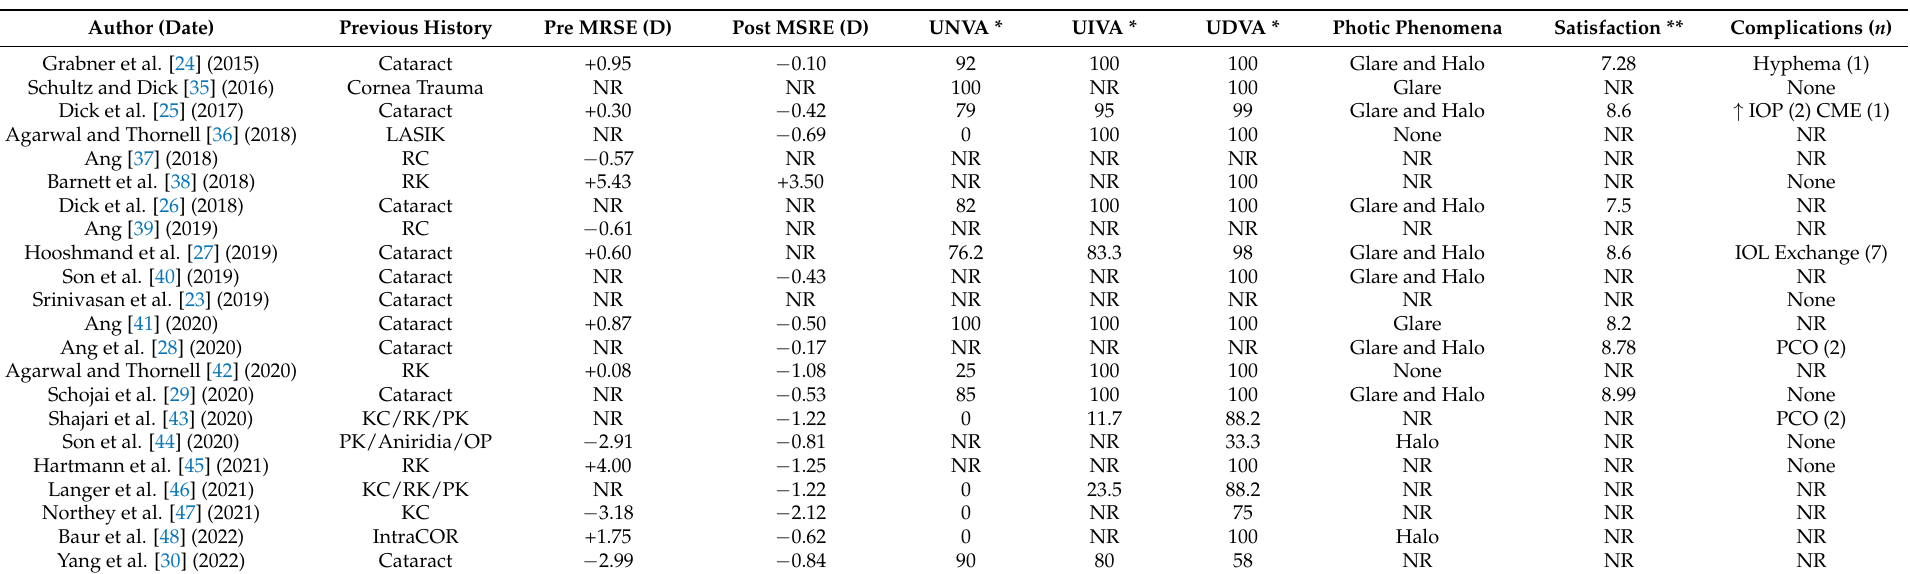
Table 3. Evaluation of the visual results after the implantation of Small Aperture Intraocular